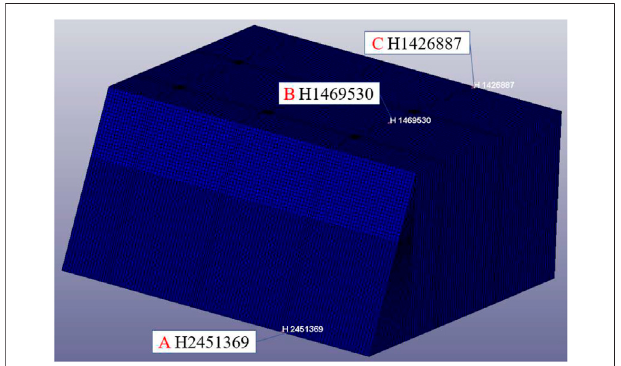
FIGURE 4 | Layout of monitoring